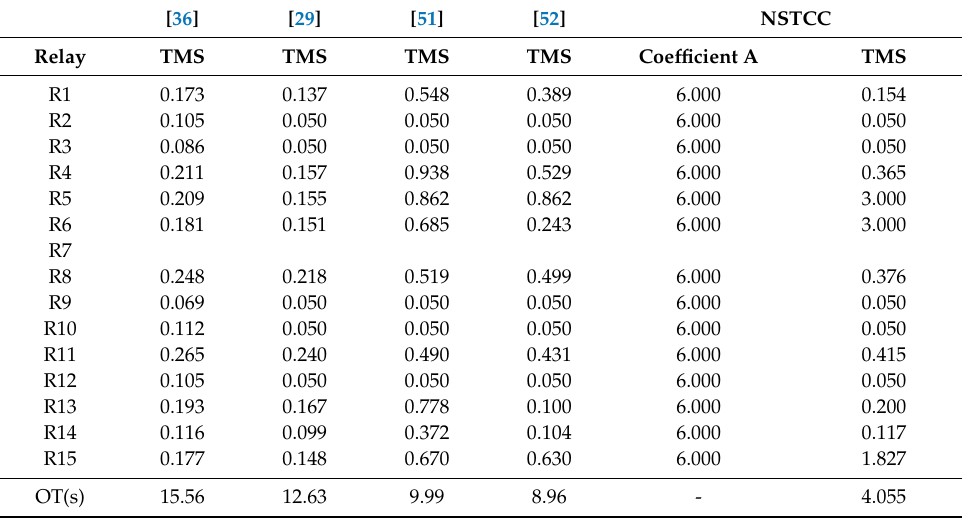
Table 8. The Overall OT for the radial IEC MG—Mode